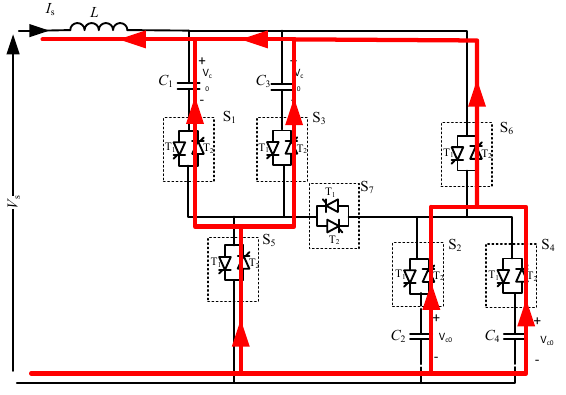
Fig. 12. Discharging path for positively charged capacitors of